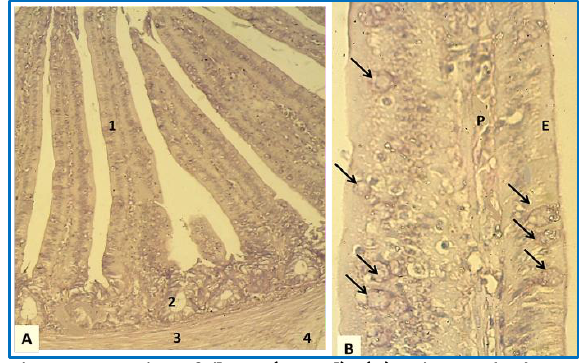
Figure, 9: Section of ileum (Kestrel), (A) Micrograph shows: Villus (1), crypt (2), inner circular layer of tunica muscularis (3) and outer longitudinal layer of tunica muscularis (4). H and E stain, 400X. (B) Micrograph shows: Epithelium (E), Lamina propria (P) and much of goblet cells (Arrows) 1000X.